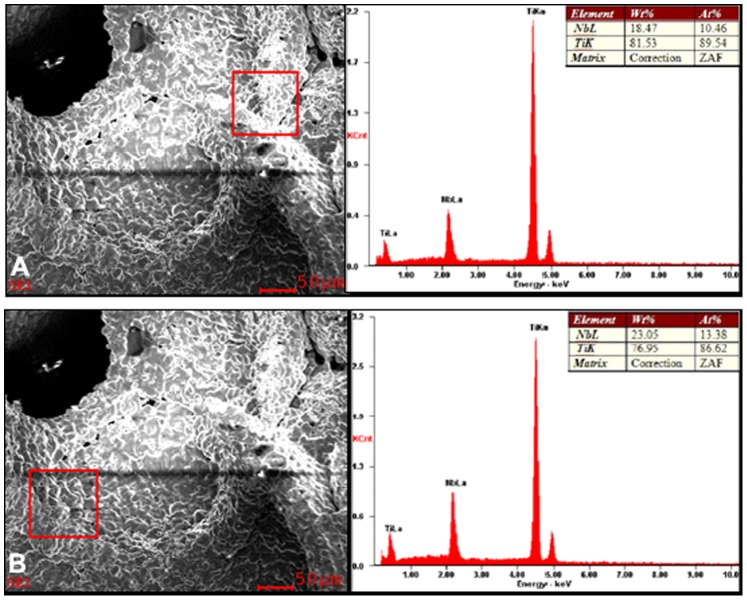
EDS analysis of alloy specimens.(A–B) EDS analysis of different regions of porous Ti-25Nb alloy.